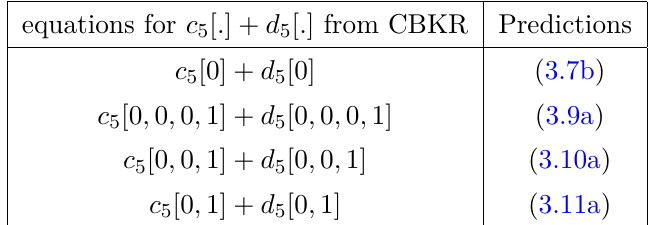
d [0 , 0 , 0 , 1] — from the prediction in eq. (3.9b). The other elements can be found 5